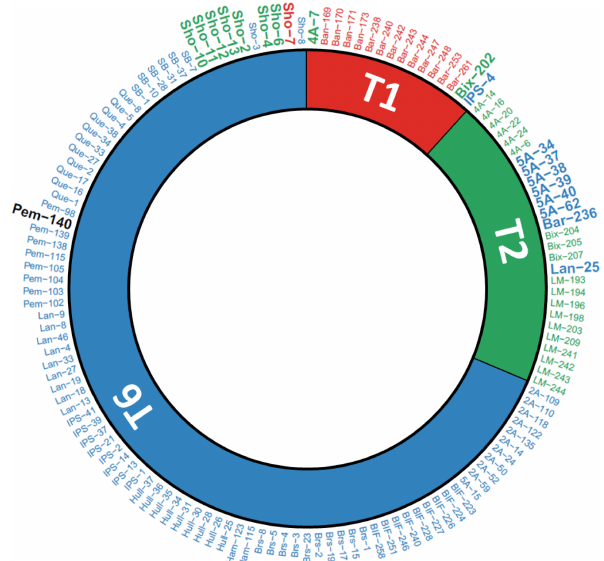
Figure 2. Circular diagram comparing molecular identification (in- ternal part of the diagram, from Saad and Wade, 2016) with mor- phological determination (external part of the diagram) for the 137 individuals investigated in this study (ordered by molecular iden- tification and their IDs). Red: T1; green: T2; blue: T6. Not deter- mined morphologically: black. Specimens for which molecular and morphological assignations mismatch or for which morphological determination was not possible are indicated in bold with a greater font